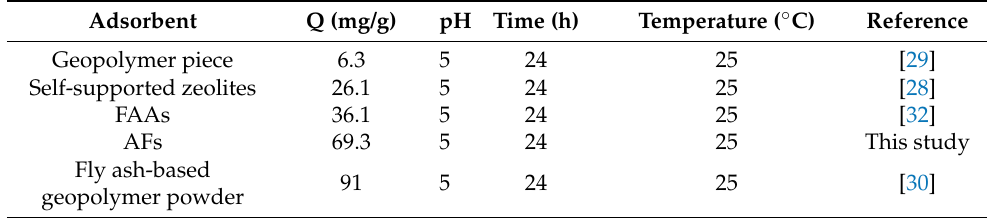
Table 4. Pb 2+ adsorption capacity onto various